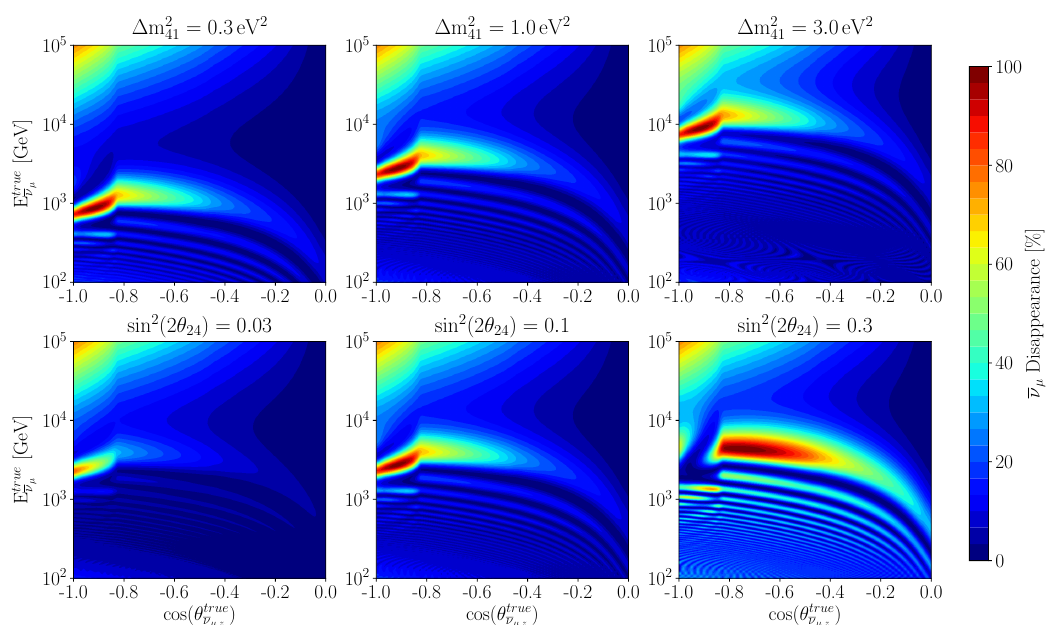
Figure 1. The survival probability for muon anti-neutrinos traveling through the Earth. For the top row sin 2 ( 2 θ 24 ) = 0.1 and ∆ m 2 is set to the value shown in the labels, for the bottom row ∆ m 2 24 labels. The calculation of the propagation is done with the nuSQuIDS library [51]. Figure from